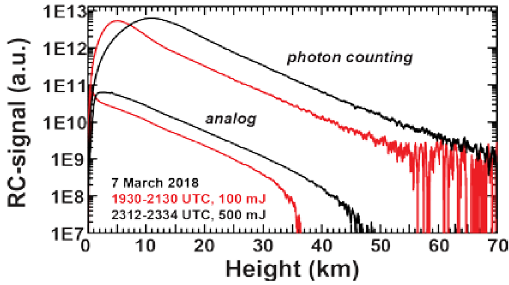
shots (209 minutes). Laser power: 1100 mJ at 354.9 nm. Grating: 1200 g/mm. Entrance slit: 50 (cid:6) m. Resolution (cid:300) 5 cm -1